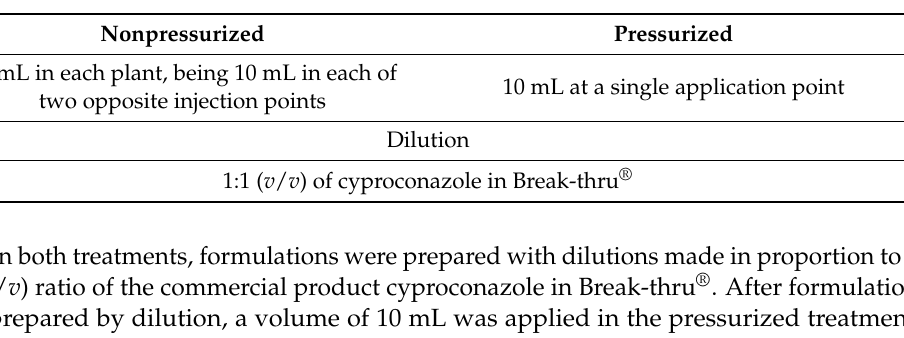
Table 1. Preparation of the solutions used in pressurized and nonpressurized endotherapeutic